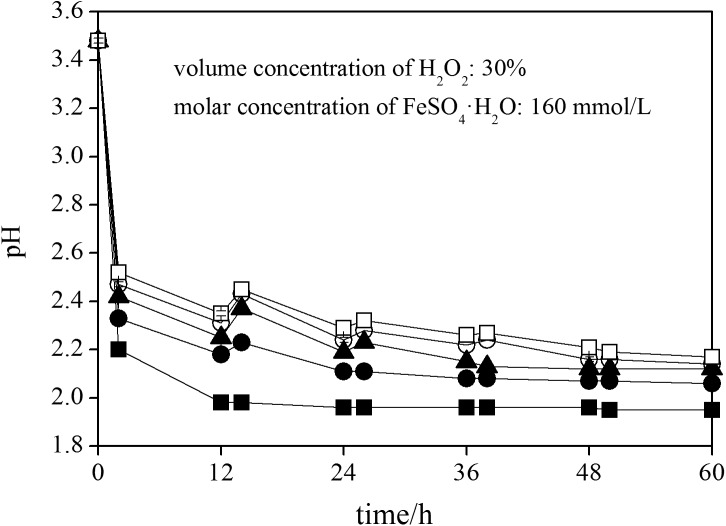
Change in pH during ferrous ions chemical oxidation with H2O2 adding FeSO4·7H2O solution at different rates.150 mL of FeSO4·7H2O solution with addition of ■: 1.80 mL of H2O2 at 2 h (treatment 1); ●: 0.90 mL of H2O2 at 2 and 14 h (treatment 2); ▲: 0.60 mL of H2O2 at 2, 14, and 26 h (treatment 3); ○: 0.45 mL of H2O2 at 2, 14, 26, and 38 h (treatment 4); □: 0.36 mL of H2O2 at 2, 14, 26, 38, and 50 h (treatment 5).